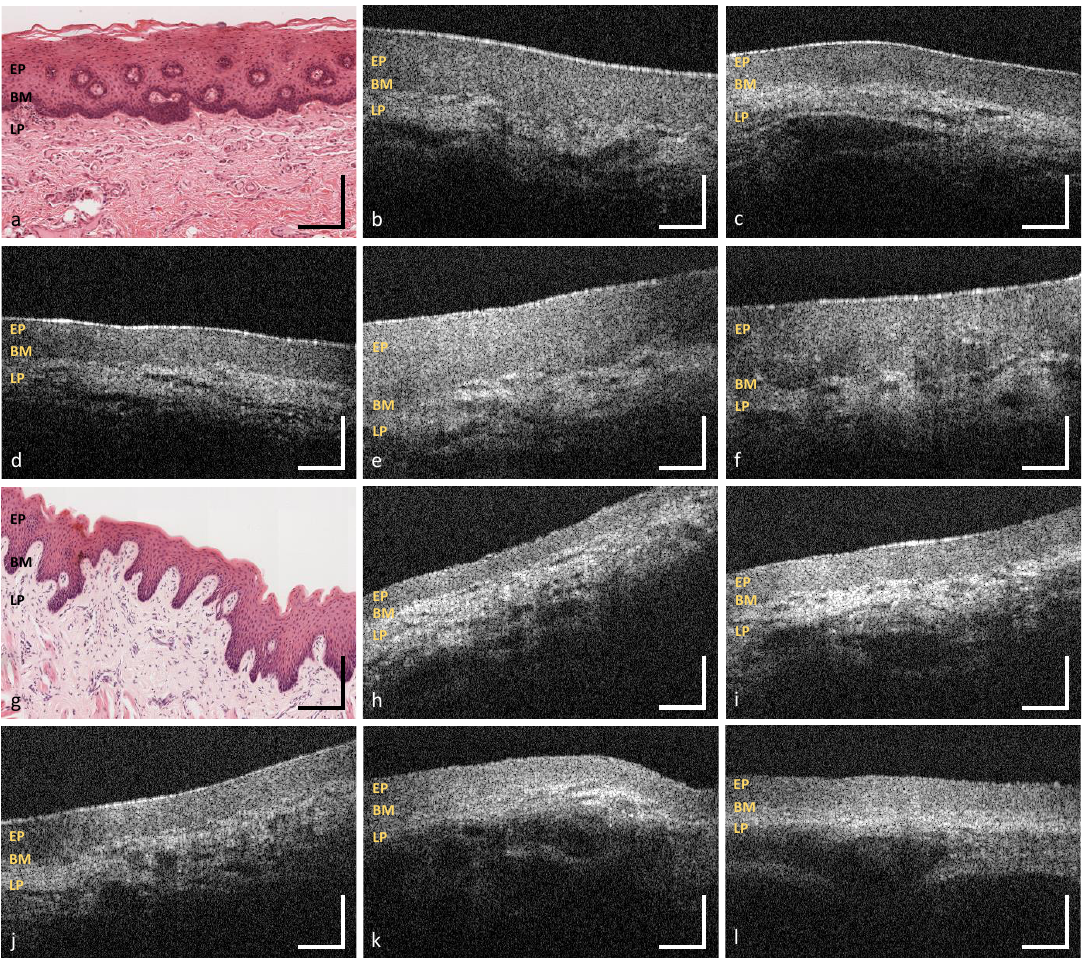
Figure 7. OCT images of the labial mucosa ( b – f ) and the alveolar mucosa ( h – l ). The sample pictures represent the upper (MP1) ( b , c ) and the lower lip (MP3,MP4) ( d – f ) as well as the upper (MP2) ( h , i ) and lower alveolar region (MP5) ( j – l ). Exemplary HE stained histological cross sections depicting the labial and the alveolar mucosa ( a , g ) ([44] modified). EP: epithelium, BM: basement membrane, LP: lamina propria. Scale bars: 200 µ